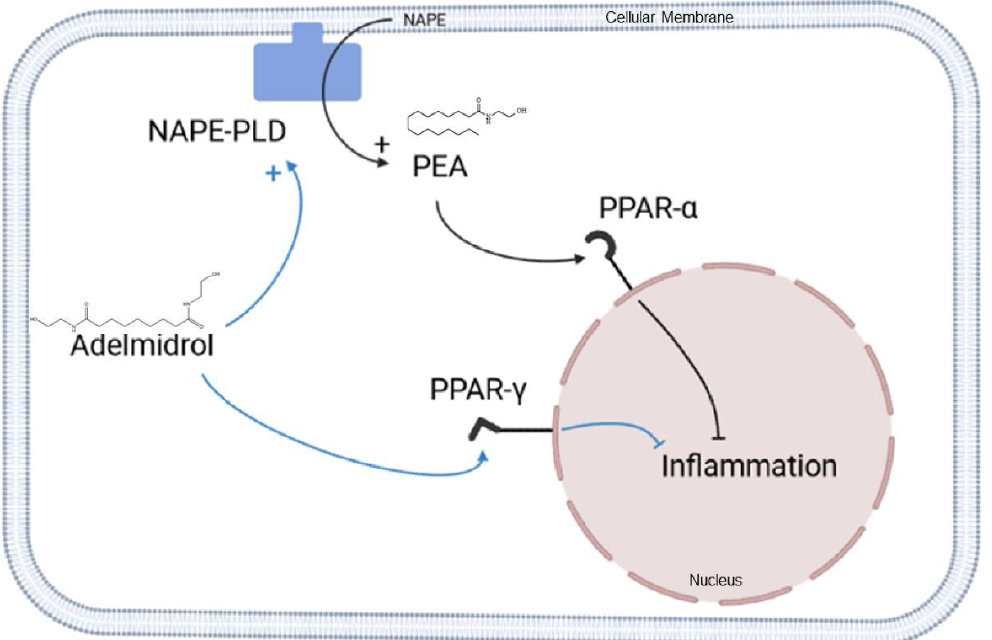
Figure 5. Adelmidrol’s main anti-inflammatory mechanism of action (blue) exerted via PPAR- γ agonism and up-regulating NAPE-PLD enzyme expression. Side-on adjuvant mechanism (Black) exerted by the increased PEA production via PPAR- α agonism. NAPE = N-acyl phosphatidylethanolamine; PLD = Phospholipase D; PEA = Palmitoylethanolamide; PPAR = Peroxisome proliferator-activated receptor.